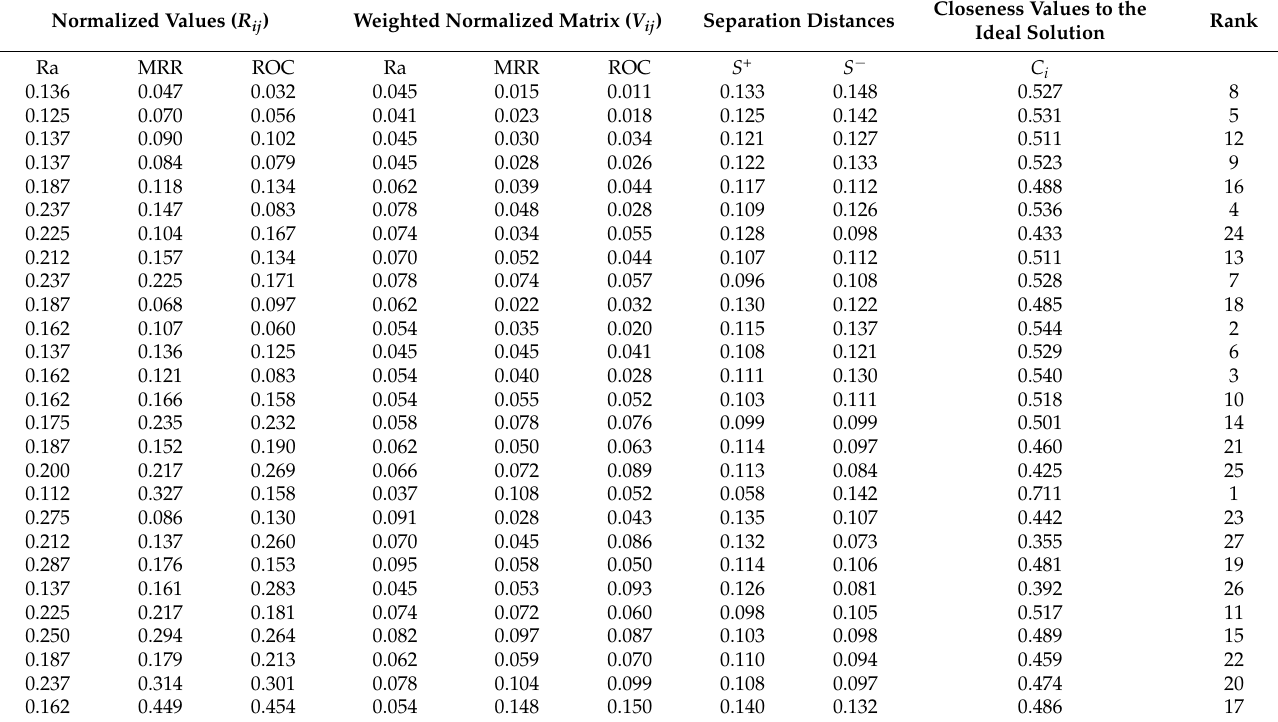
Table 8. Table showing the application of TOPSIS for